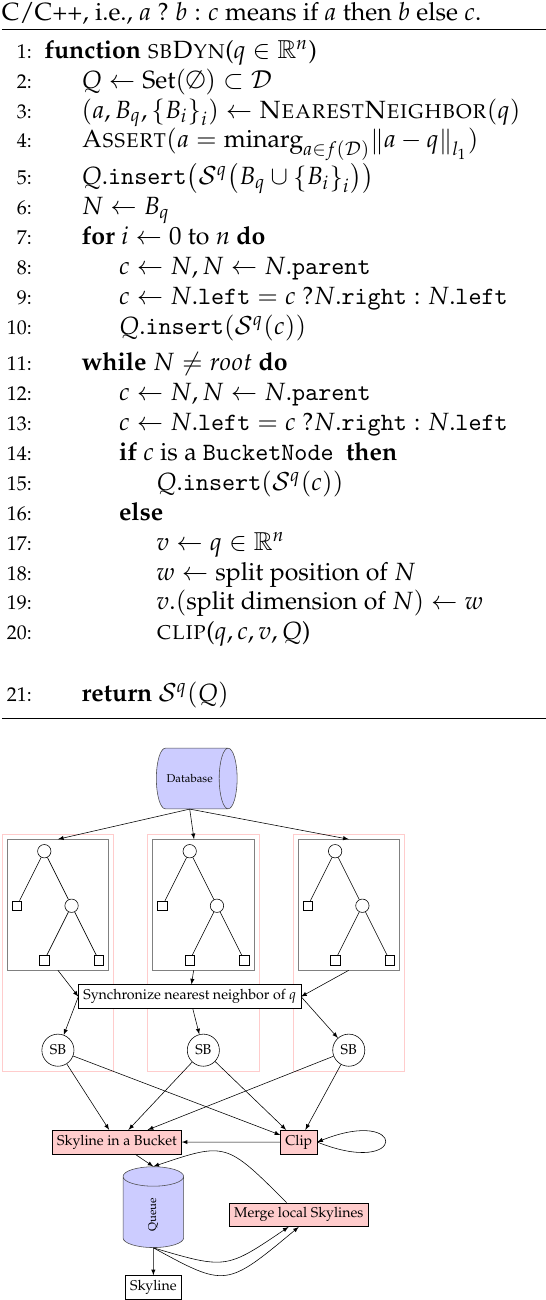
Algorithm 1 Dynamic Skyline Breaker: The ternary ? operator has the same semantic as in